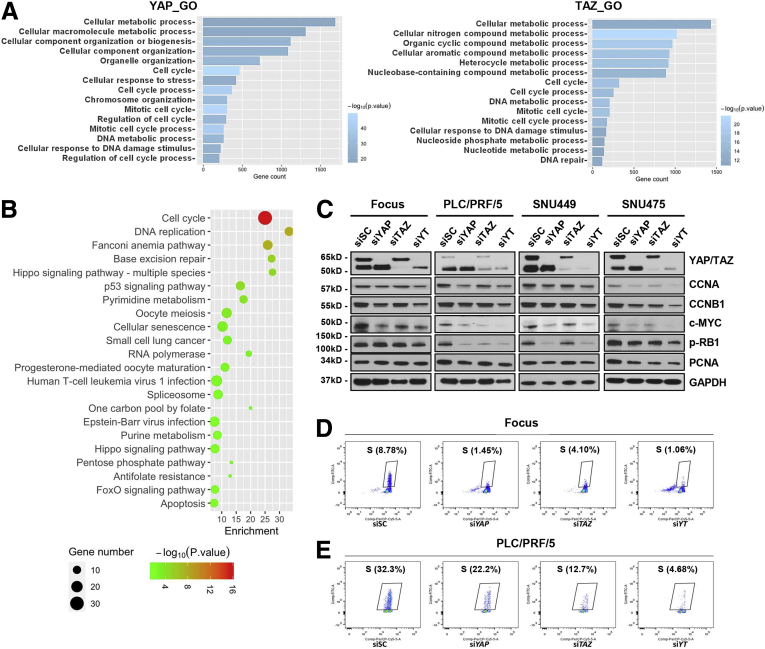
YAP and TAZ regulate cell cycle and DNA replication during hepatocarcinogenesis. (A) Gene Ontology (GO) analysis of YAP and TAZ correlated genes from the TCGA Liver Hepatocellular Carcinoma (LIHC) data set. (B) KEGG analysis of differentially expressed genes in YAP and TAZ concomitantly silenced (siYT) HCC cell lines. Ranked by P value. (C) Western blot analysis showing the level changes of cell-cycle–related proteins after silencing of YAP (siYAP), TAZ (siTAZ), and the 2 genes combined (siYT). Glyceraldehyde-3-phosphate dehydrogenase (GAPDH) was used as a loading control. (D and E) Enhanced cell-cycle arrest in the (D) Focus and (E) PLC/PRF/5 human HCC cell lines treated with specific siRNA against YAP and/or TAZ (siYAP and/or siTAZ). The percentages of cells in the S phase are shown. FoxO, Forkhead box subfamily O.